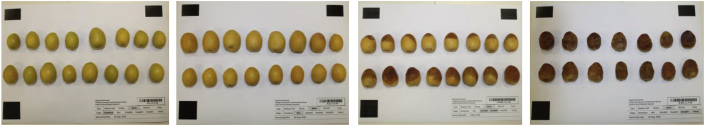
64-individual Barhi dates at the four maturity stages (16 dates per stage): immature, Khalal, Rutab, and Tamar.